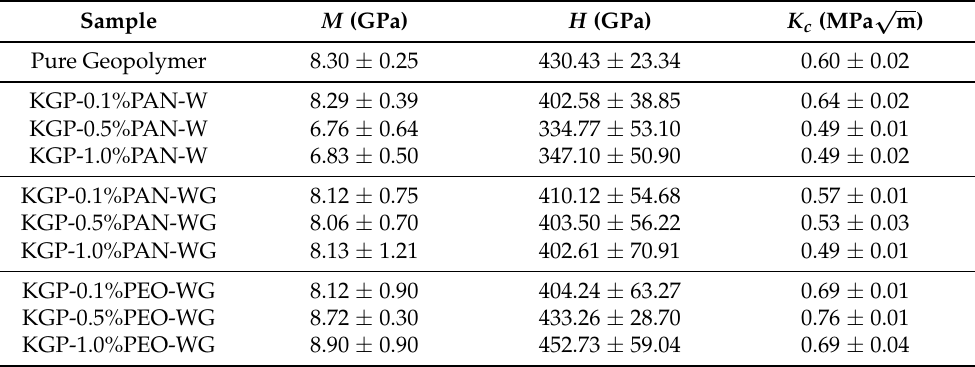
Table 6. Mechanical properties of electrospun-fiber-reinforced geopolymer composites. M is the average indentation modulus, H is the average indentation hardness, and K c is the average frac- ture